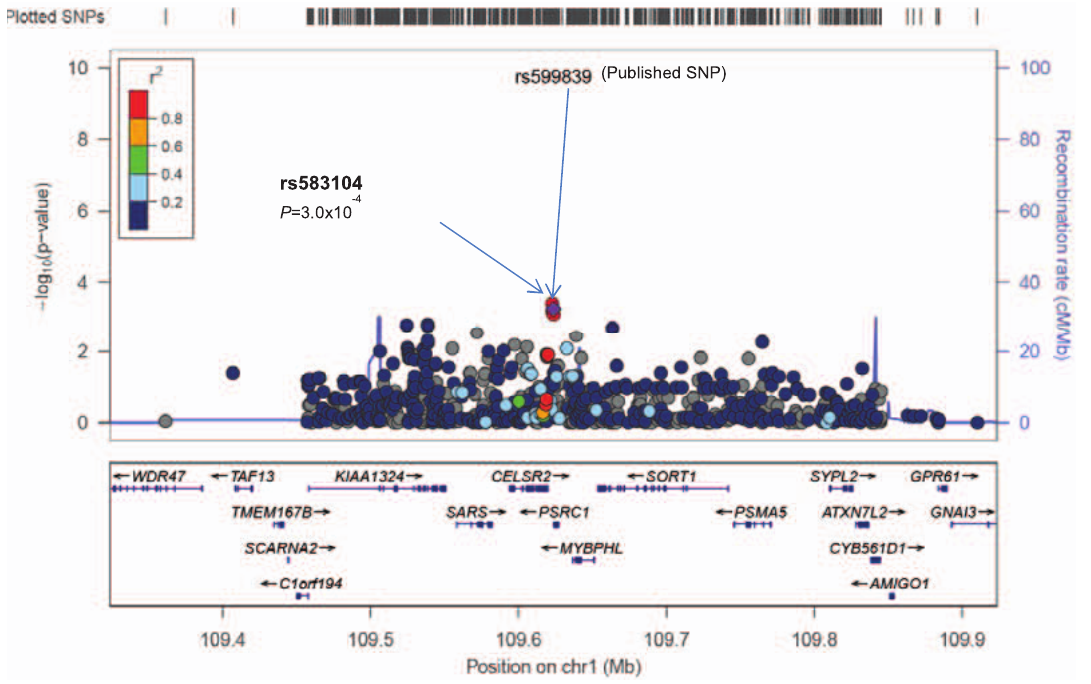
Fig. 1. Regional plots of validated loci showing replication of the published SNP or proxy (a) or novel SNPs in known CHD loci (b, c). The X-axis shows chromosomal positions and genes, the left Y-axis shows the –log10P-values and the right Y-axis shows the recombination rate across the region using HapMap CEU linkage disequilibrium. Plotted SNP is the published SNP and is marked by a purple diamond and an